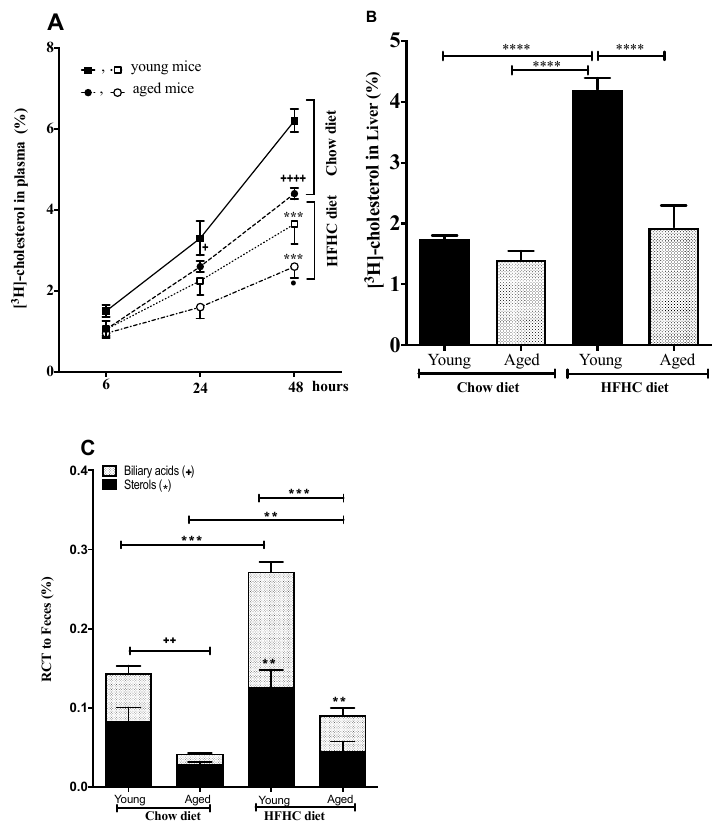
Figure 1. Effect of an atherogenic diet on RCT in young and aged mice. Young and aged mice (3- and 20-month-old mice, respectively) were fed chow or an HFHC diet for 12 weeks. [ 3 H]-cholesterol-loaded J774 macrophages were intraperitoneally injected into the mice, and [ 3 H]-cholesterol plasma levels were measured at 6, 24, and 48 h post-injection. Feces were collected continuously from 0 to 48 h post-injection. ( A ) Time course of 3 H-cholesterol distribution in plasma. ( B ) 3 H-cholesterol recovery in the liver after 48 h. ( C ) 3 H-cholesterol recovery in the feces as sterols and biliary acid. Data are expressed as means ± SEM versus chow. n = 5 mice/group. ** p < 0.005, *** p < 0.001, **** p < 0.0001 versus chow diet, + p < 0.015, ++ p < 0.005 and ++++ p < 0.0003 young vs. aged mice.